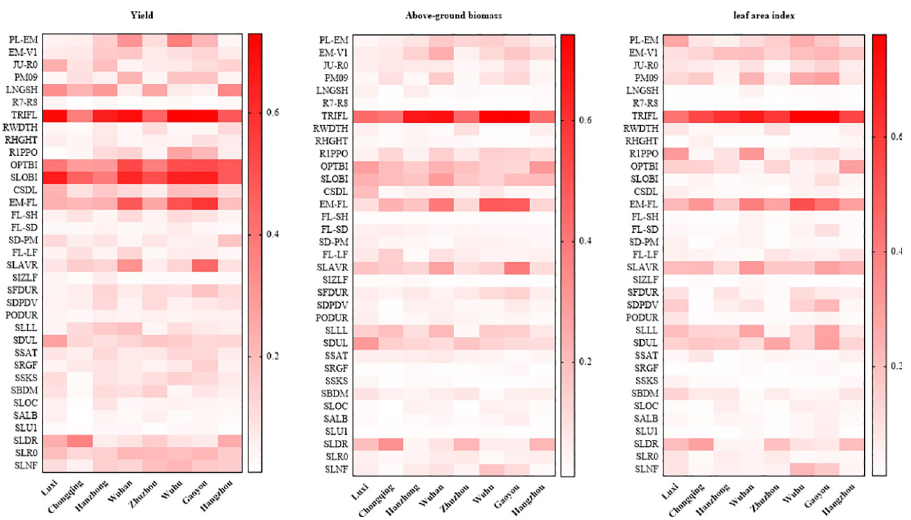
Fig 4. Spatial sensitivity indices of yield, aboveground biomass and LAI to input parameters. Note . I: ecotype parameters; II: genotype parameters; III: soil parameters.